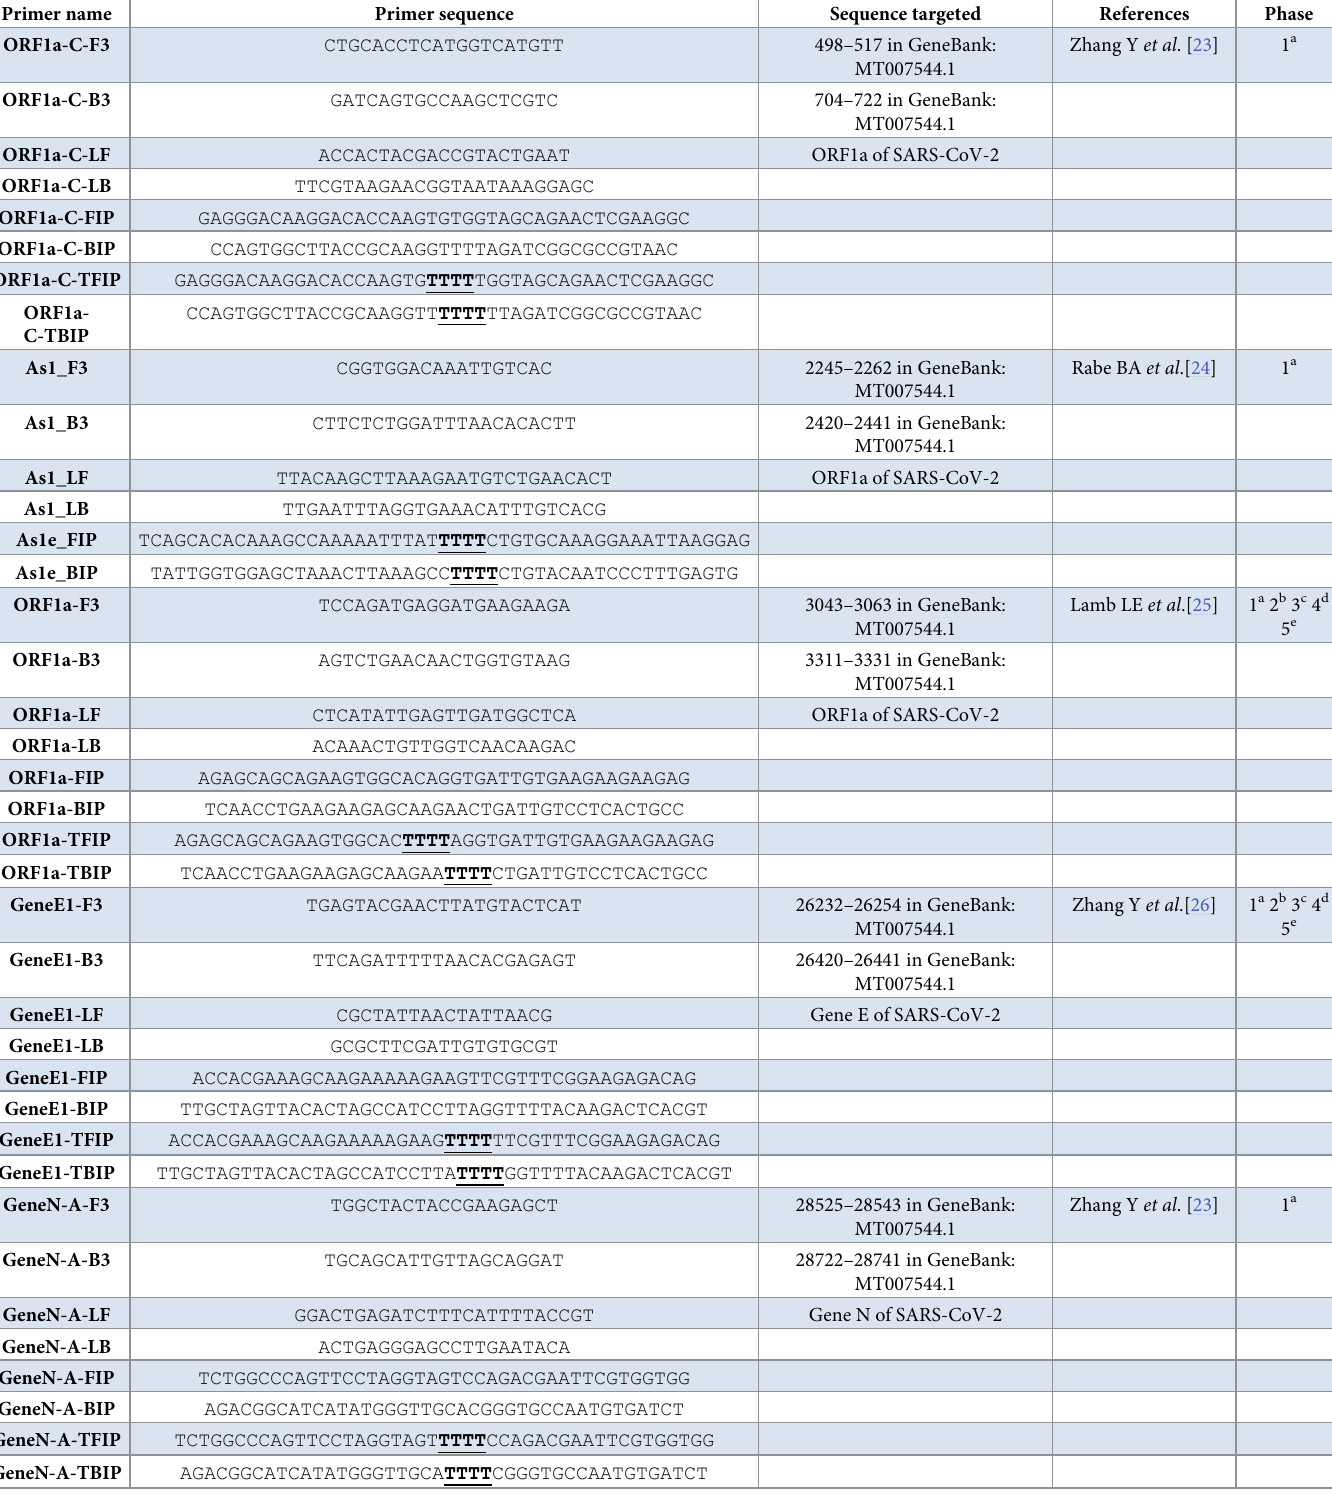
Table 1. Primer sets that were optimized for